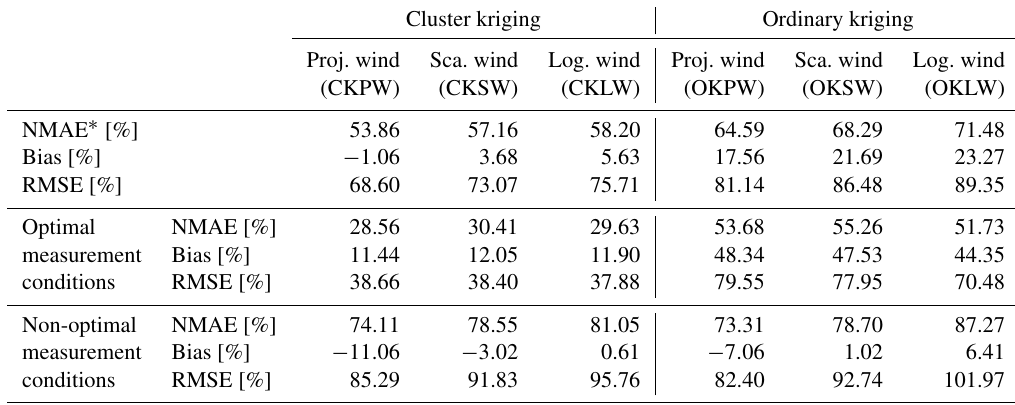
Table 2. Summary of performance of each quantification